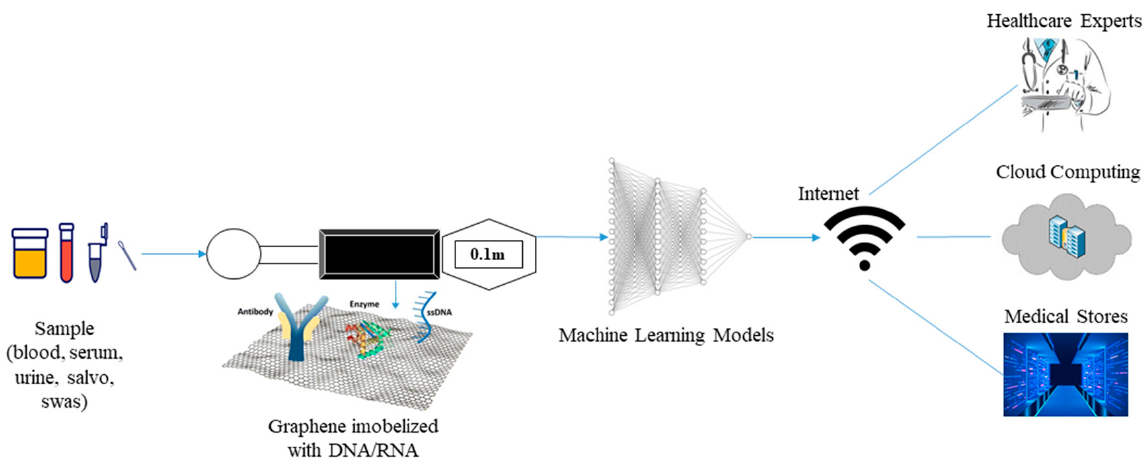
Figure 5. Proposed